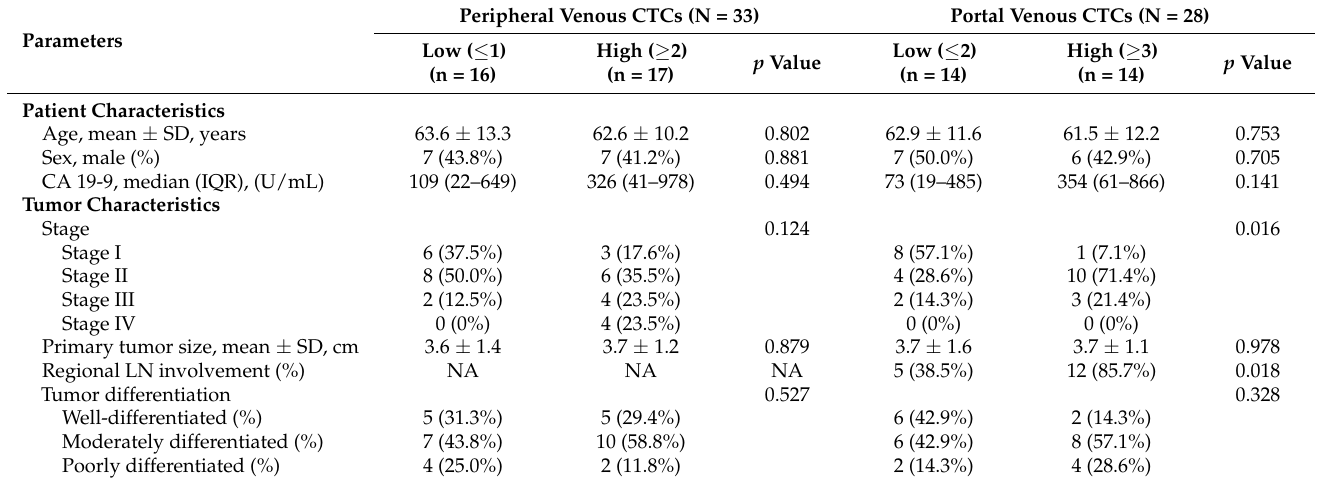
Table 2. Factors associated with low vs. high number of CTCs from peripheral and portal venous